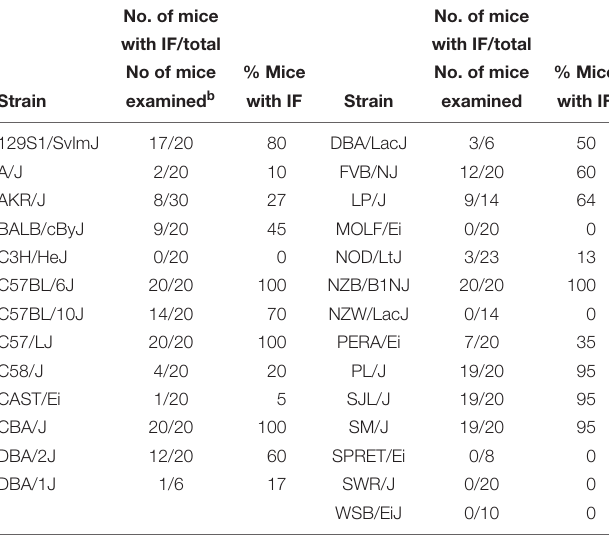
TABLE 1 | Survey of Interfrontal bones (IFs) among inbred mouse strains a